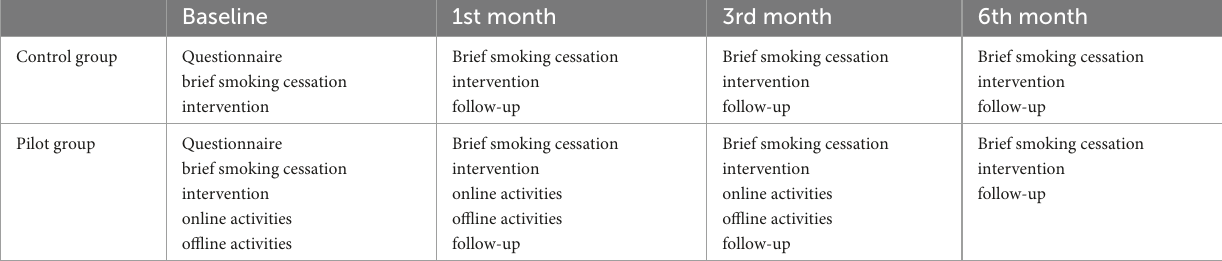
TABLE 1 Interventions in the pilot and control groups.